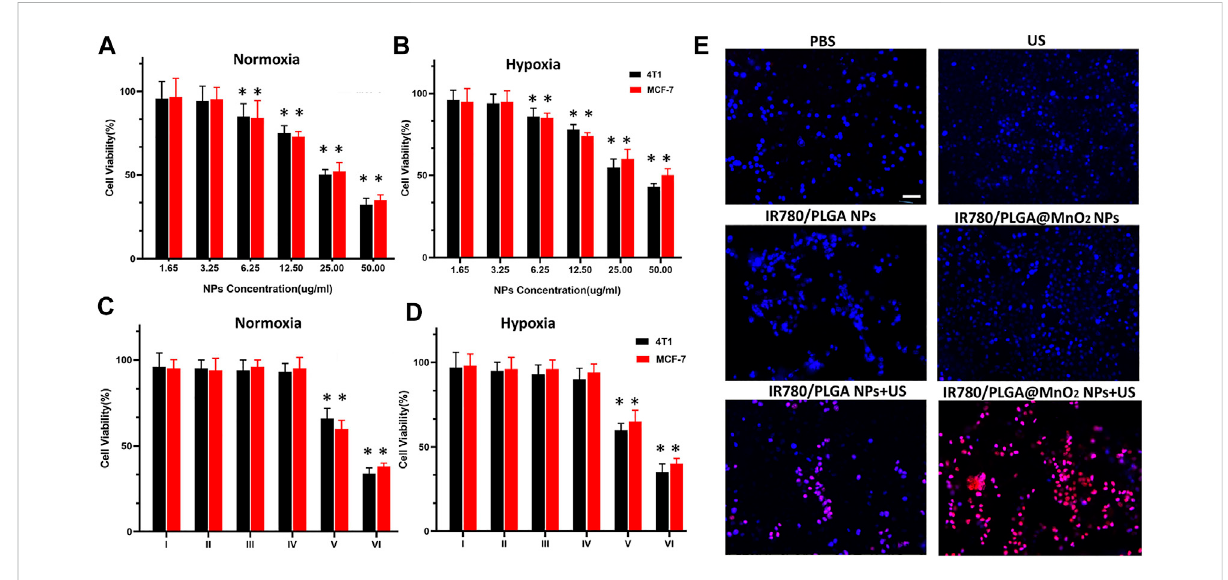
FIGURE 5 (A,B) Cell viability of 4T1 and MCF-7 cells incubated with different concentrations of IR780/PLGA@MnO2 NPs under normoxia environment (A) and hypoxia environment (B) . (C,D) Cell viability of 4T1 and MCF-7 cells under different treatments: (I) PBS, (II) US, (III) IR780/PLGA NPs, (IV)